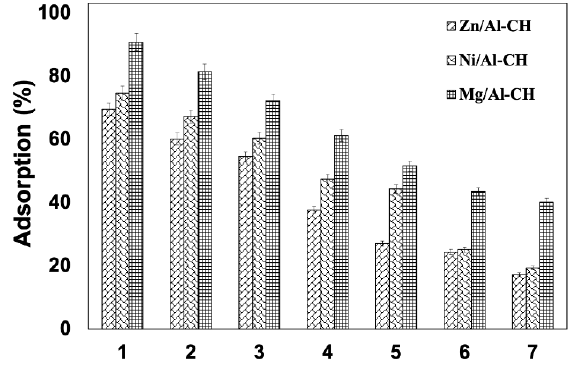
Figure 8. Regeneration of Zn/Al-CH, Ni/Al-CH, and